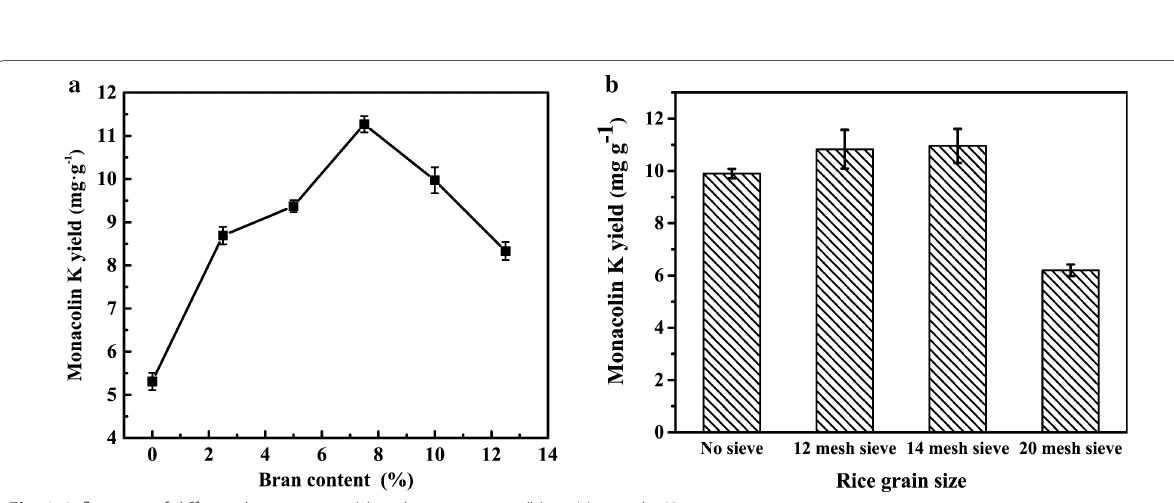
Fig. 3 Influences of different bran content (a) and rice grain size (b) on Monacolin